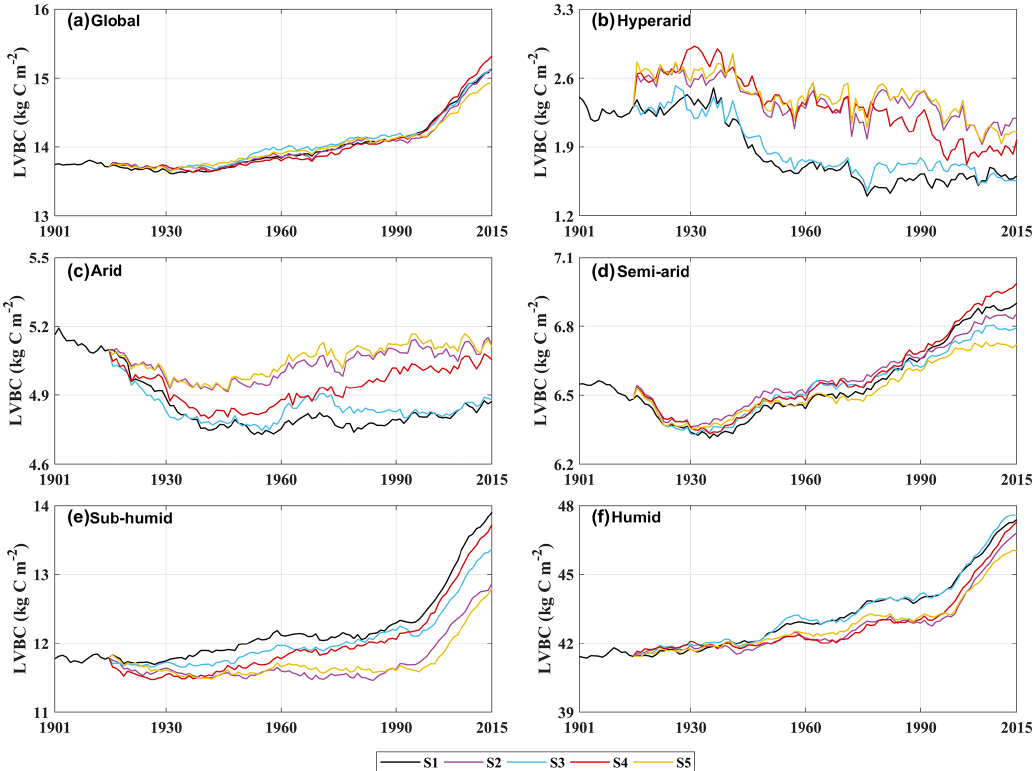
Figure A7. Trends in average density of potential LVBC. (a) Modelled trend of annually averaged LVBC globally. Modelled trends in annually averaged LVBC in hyper-arid regions (b) , arid regions (c) , semi-arid regions (d) , sub-humid regions (e) , and humid regions (f) .